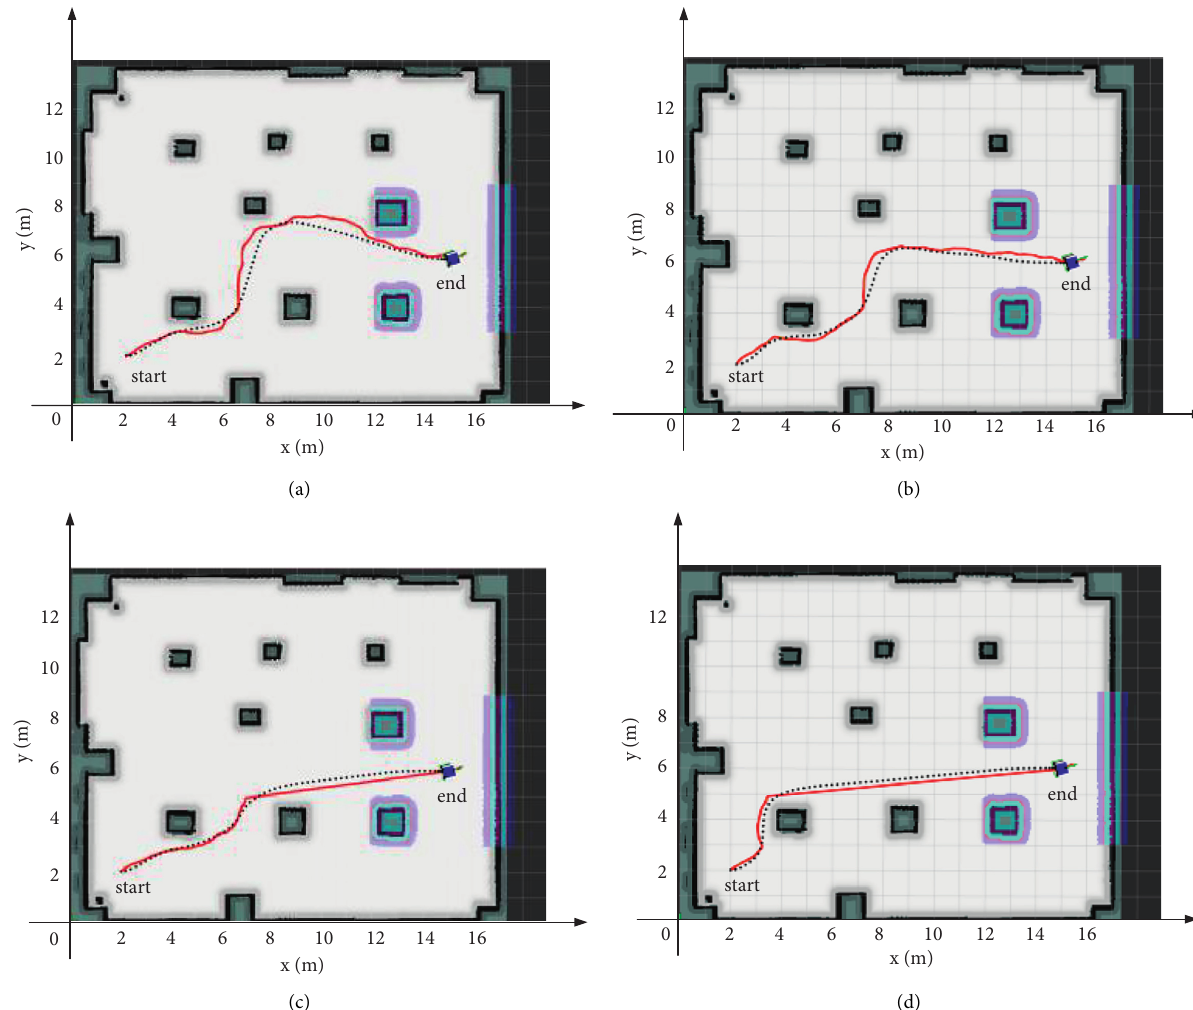
Figure 9: Autonomous navigation maps based on the two Informed-RRT ∗ algorithms before and after the